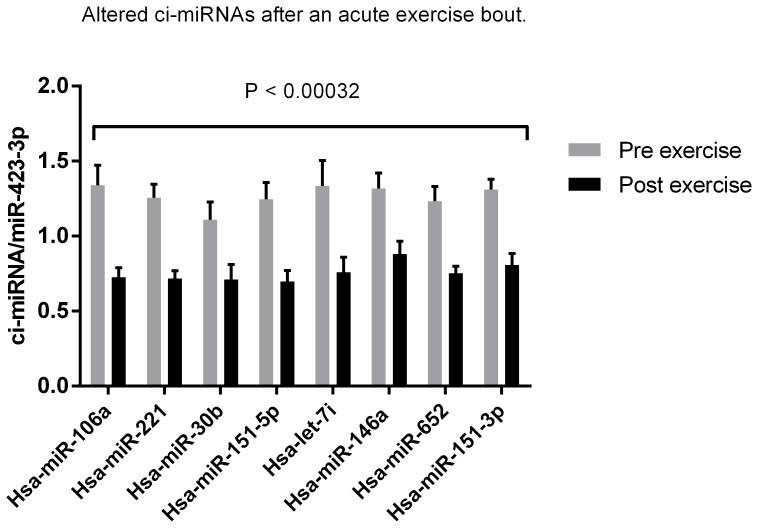
Alterations in ci-miRNAs in plasma immediately after an acute exercise bout.Eight ci-miRNAs were down regulated after a single 60 min aerobic exercise bout at 65% Pmax. Ci-miRNAs below the Dunn-bonferroni corrected p-value P<0.00032 was considered as significant altered.